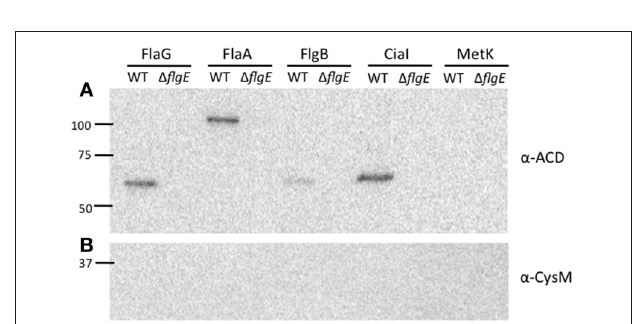
FIGURE A3 | FlaG, FlaA, FlgB, and CiaI are secreted through the flagellar T3SS. Secretion of the FlaG-, FlaA-, FlgB-, CiaI-, and MetK-ACD fusion proteins from the C. jejuni wild-type strain and flgE mutant was examined. The C. jejuni strains were transformed with the various ACD plasmids, and Cia secretion was stimulated by the addition of FBS. After 3h, the proteins in the supernatant fractions were precipitated and an immunoblot was performed using an anti-ACD (A) and anti-CysM (B) antibodies. MetK-ACD was included as a negative control, as it is not secreted from C. jejuni . The molecular mass of the pre-stained protein standards are listed in